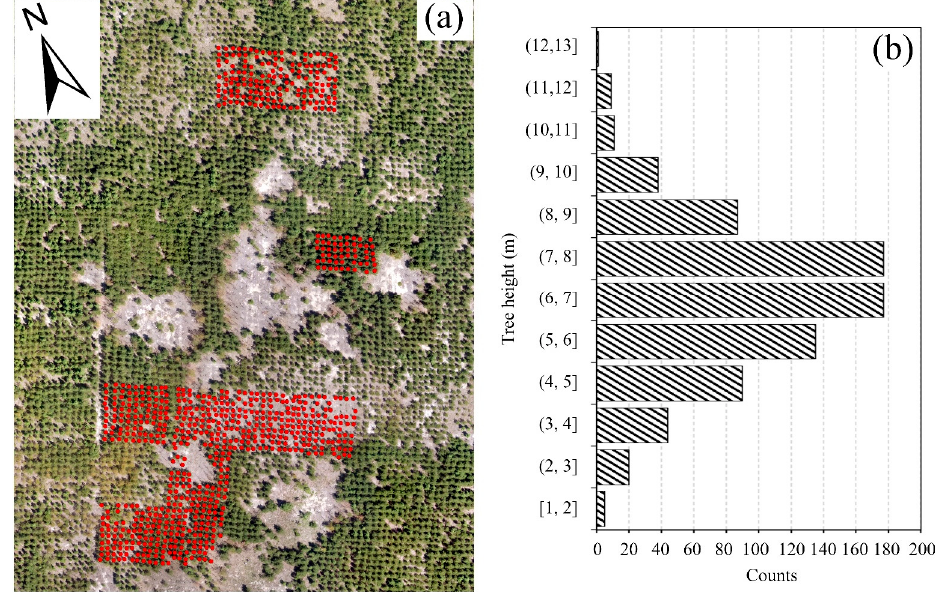
Figure 2. The distribution of field-surveyed trees ( a ) and tree heights ( b ).